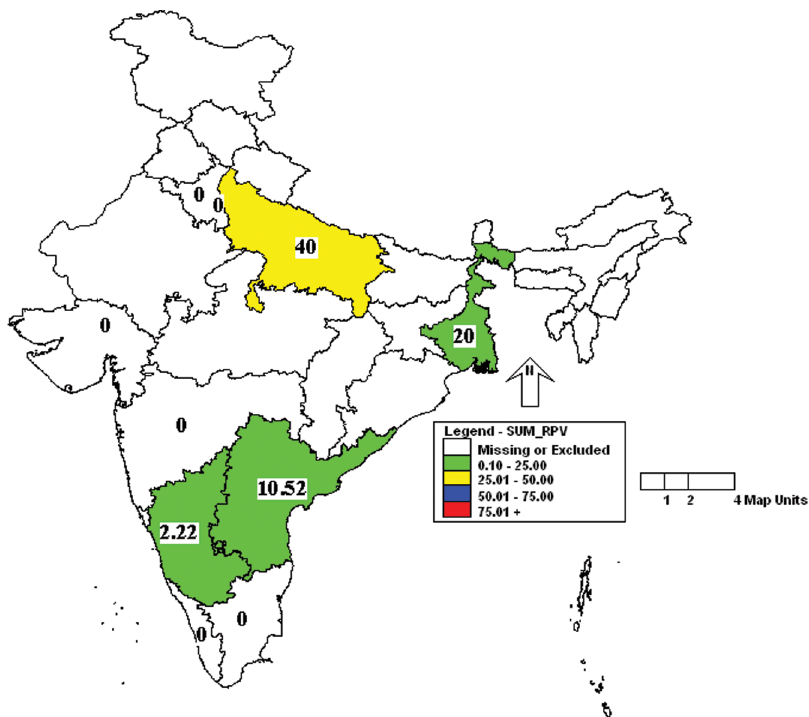
Fig 6. Incidence of rat parvovirus (RPV) in different states of India. Green — 00.00 to 25.00%; Yellow — 25.01 to 50.00%.